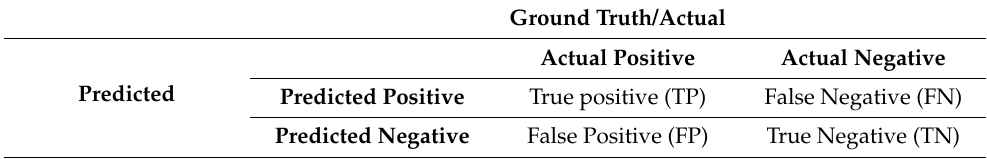
Table 3. Overview of confusion matrix/contingency